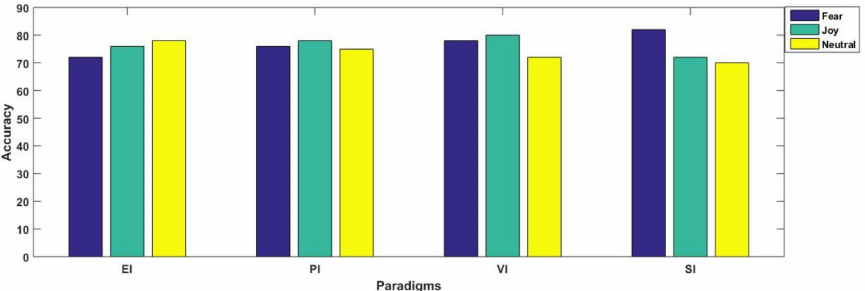
Figure 7. Comparing classification performance for each of the three emotional states in each of the four considered emotion-evoking